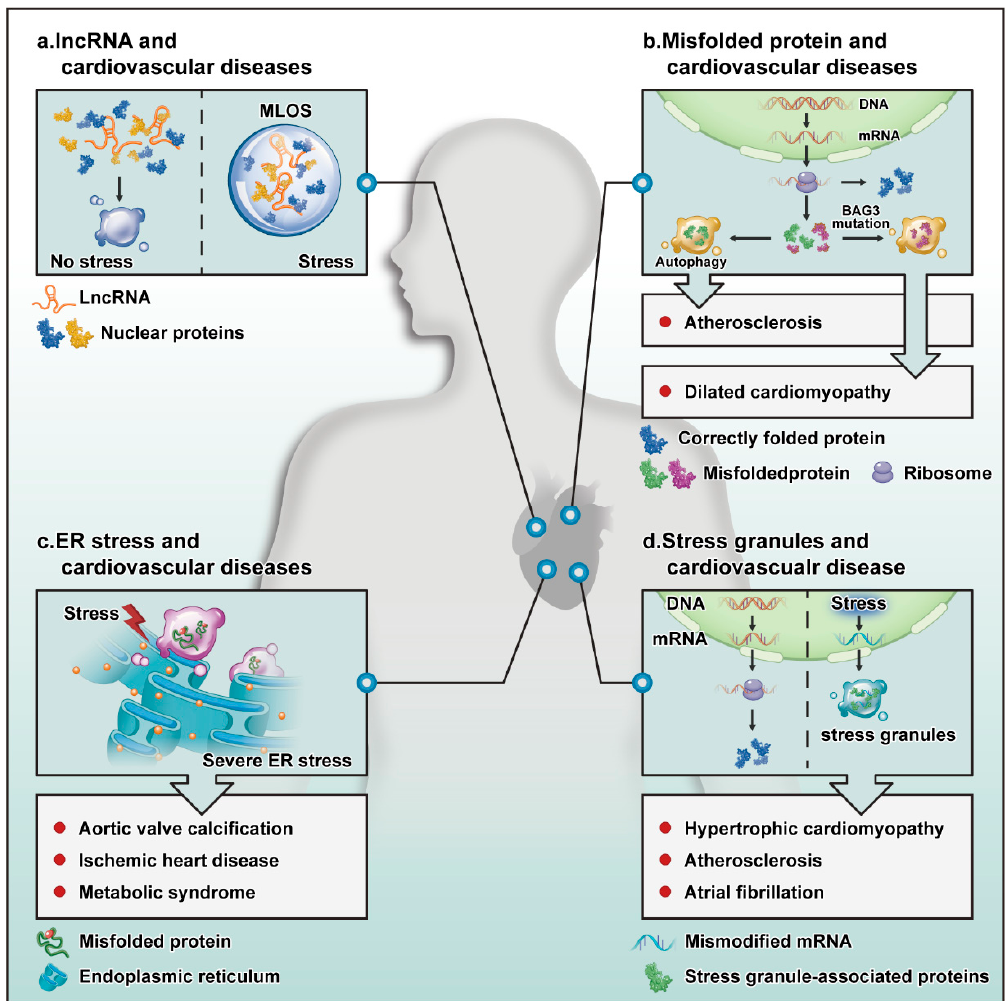
Figure 2. Potential role of LLPS in the cardiovascular system. ( a ) When stress occurs, lncRNAs become the core of droplets formed by liquid–liquid separation. ( b ) A correctly translated protein (blue) will perform its normal biological activities. Some misfolded proteins (green) are eliminated by autophagy to protect against atherosclerosis. Mutated or excessively produced proteins (red) accumulate, causing DCM. ( c ) The accumulation of a large number of misfolded proteins in the endoplasmic reticulum leads to endoplasmic reticulum stress, which can affect aortic valve calcification, ischemic heart disease, and metabolic syndrome. ( d ) Mistranscribed or modified mRNAs are eliminated by SG formation in the cytoplasm. This process can affect the progression of hypertrophic cardiomyopathy, atherosclerosis, and atrial fibrillation. Abbreviations are as follows: ER stress, endoplasmic reticulum stress; MLOs, membrane-free organelles.